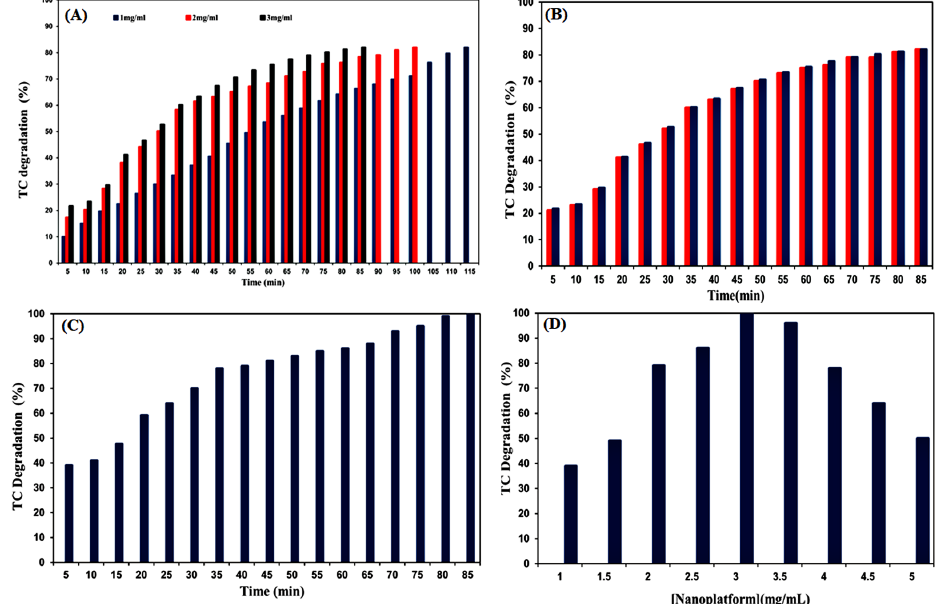
Figure 7. Effects of different concentrations of nanoplatform ( A ), H 2 O 2 ( B ), incubation time ( C ), and the concentration of magnetite/Gd 3+ /β - cyclodextrin nanoplatform ( D ) on the degradation of TC in the presence of H 2 O 2 .